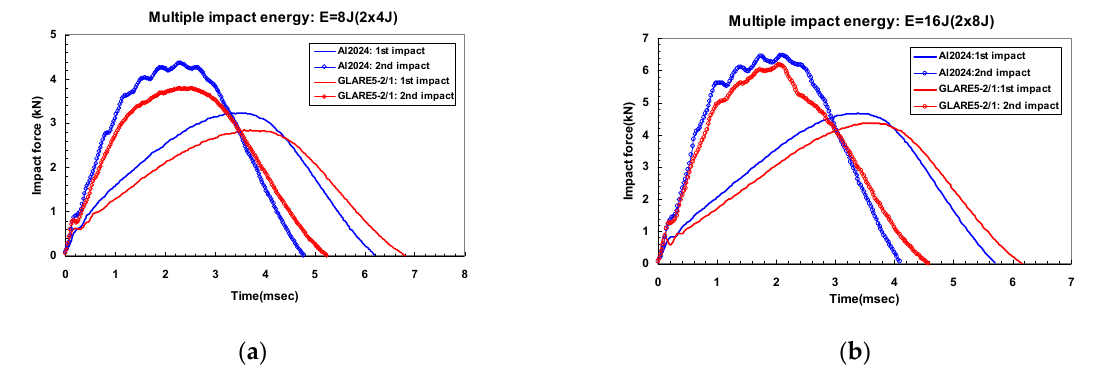
Figure 7. Multiple impact damage of GLARE 5-2/1 at ( a ) BVID (8 J (2 × 4 J)), ( b ) BVID (16 J (2 × 8 J)), ( c ) CVID (26 J (2 × 13 J)).